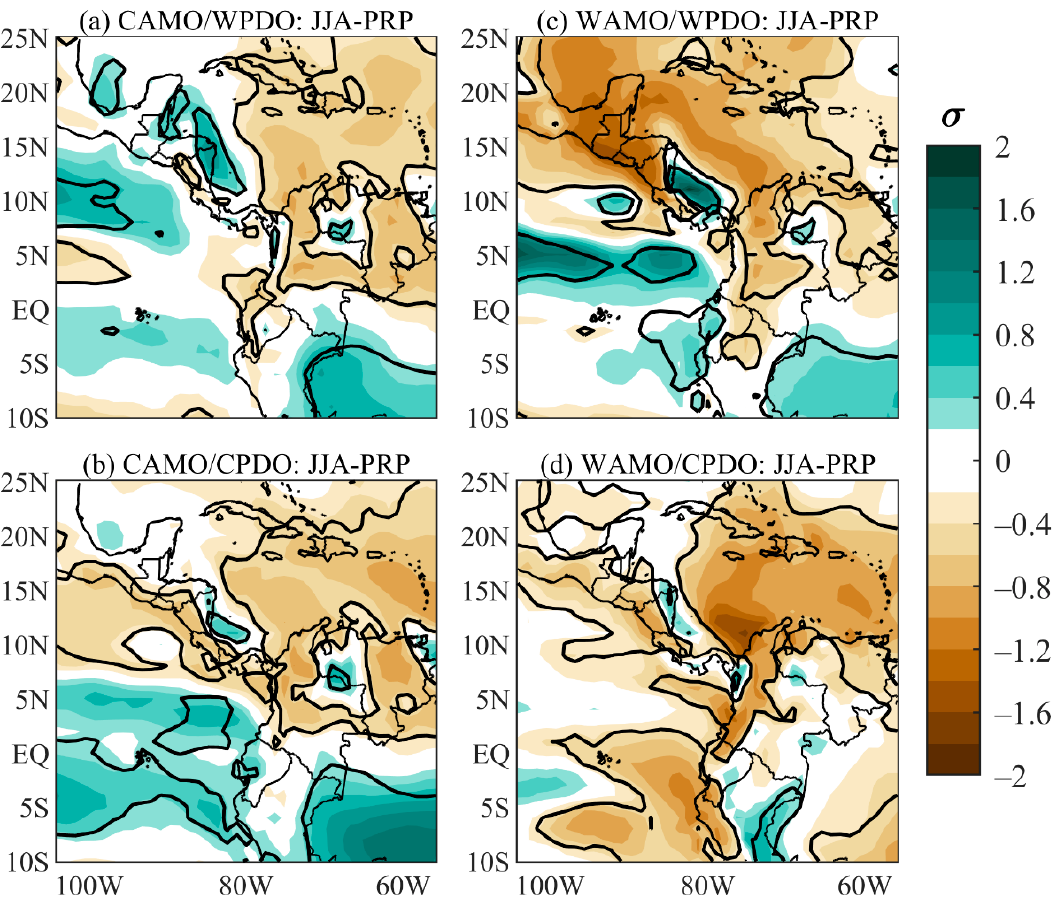
Figure 9. June–August precipitation standardized anomalies over Central America and northwestern South America during intense CLLJ events of the: ( a ) CAMO/WPDO; ( b ) CAMO/CPDO; ( c ) WAMO/WPDO; and ( d ) WAMO/CPDO mean states. Display is same as Figure 6.